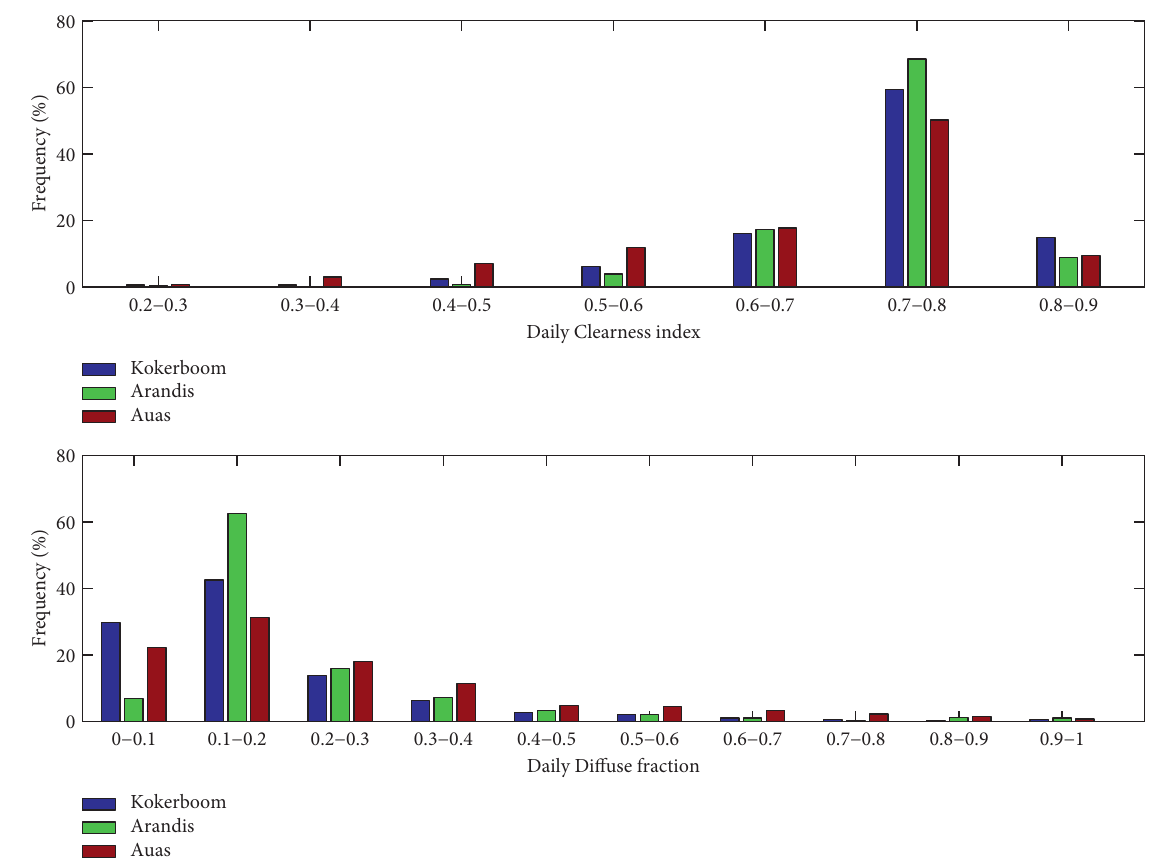
Figure 2: Frequency distribution of Clearness index and diffuse